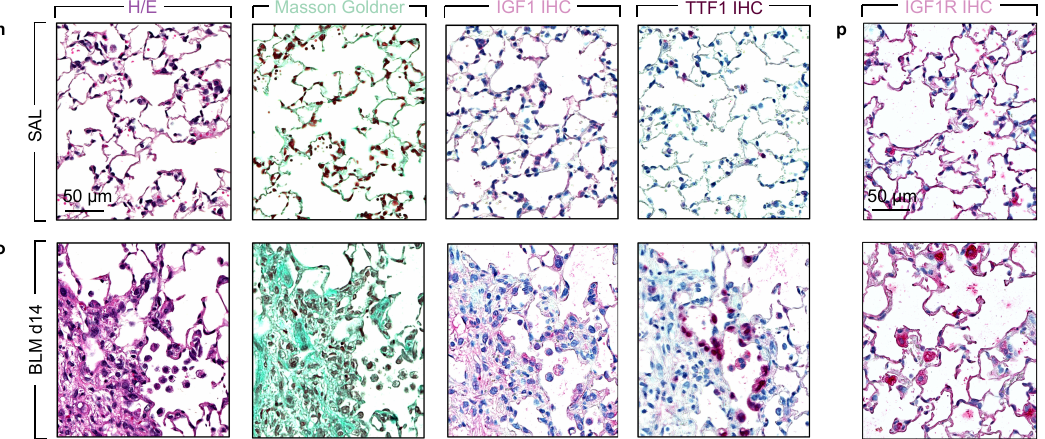
Figure 2. Alteration of IGF signaling in the bleomycin model of lung fibrosis. ( a , b ) Hematoxylin/eosin and Masson Goldner staining showing clear fibrosis in bleomycin-treated mouse lungs compared with saline-treated controls. ( c ) Western blot for PAI-1, COL1A1 and ACTB. ( d – m ) qPCR on lung homogenates at the indicated timepoints. ( n , o ) Hematoxylin/eosin stain, Masson Goldner stain, IGF1 immunohistochemistry and TTF1 immunohistochemistry on saline- and bleomycin-treated mouse lungs. ( p ) IGF1R immunohistochemistry on saline- and bleomycin-treated mouse lungs. One-way ANOVA was used to compare the means. SAL: n = 6, BLM d7: n = 4, BLM d14: n = 4. * p < 0.05, ** p < 0.01, *** p < 0.001. SAL: Saline; BLM: Bleomycin; IHC: